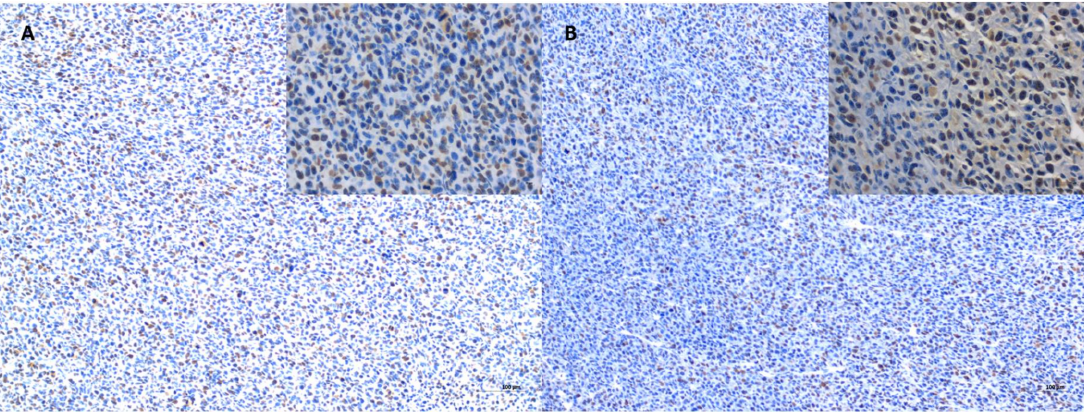
Figure 13. Immunoexpression of Ki-67 in the tumor core after treatment with Au-GSH-Dox ( A ) and Dox ( B ). Bar graph 100 µ m and 20 µ m